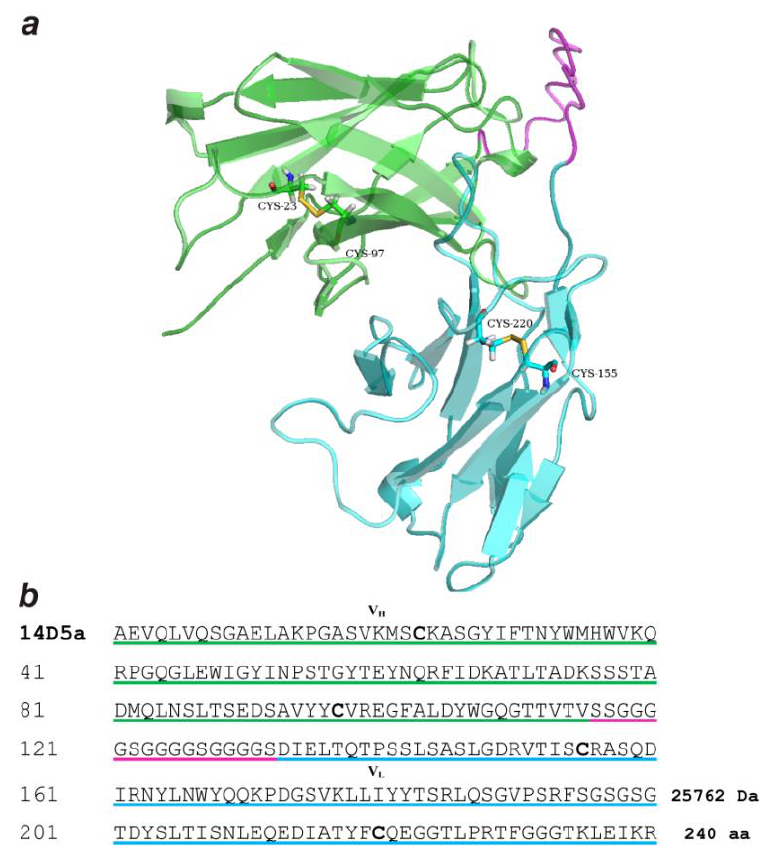
Figure A2. ( a ) Model for spatial structure of 14D5a single-chain antibody predicted by I-TASSER on-line service [47–49] showing the presence of two S-S bonds in a properly folded protein. C-score was estimated to equal 0.69 that indicates a high quality of the predicted model [47–49]. Cys residues forming disulfide bridges are labeled. ( b ) Amino acid sequence of 14D5a single-chain antibody. The VH and VL domains, and 17 a/a GS-bridge are underlined by green, cyan, and pink, respectively. Cys residues are shown in bold.